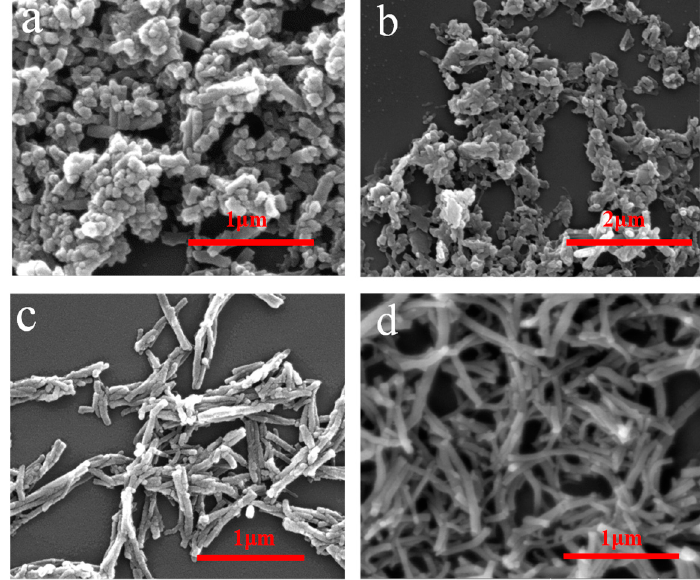
Figure 3. Scanning electron microscope (SEM) images of PANI ( a ), PANI@CNs nanowhiskers with the weight ratio CNs/aniline (1:6) ( b ), (1:4) ( c ), and (1:2) ( d ).